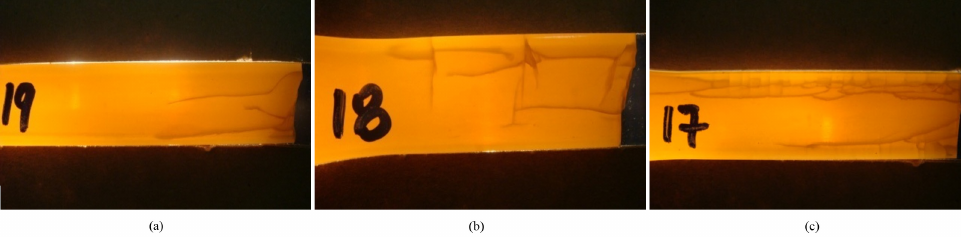
Figure 10. Macrophotographic images of sample surfaces of PHB-2 after tensile testing at 2 mm/min exposed to NaOH, preloads: (a) 231N, (b) 461N, (c)